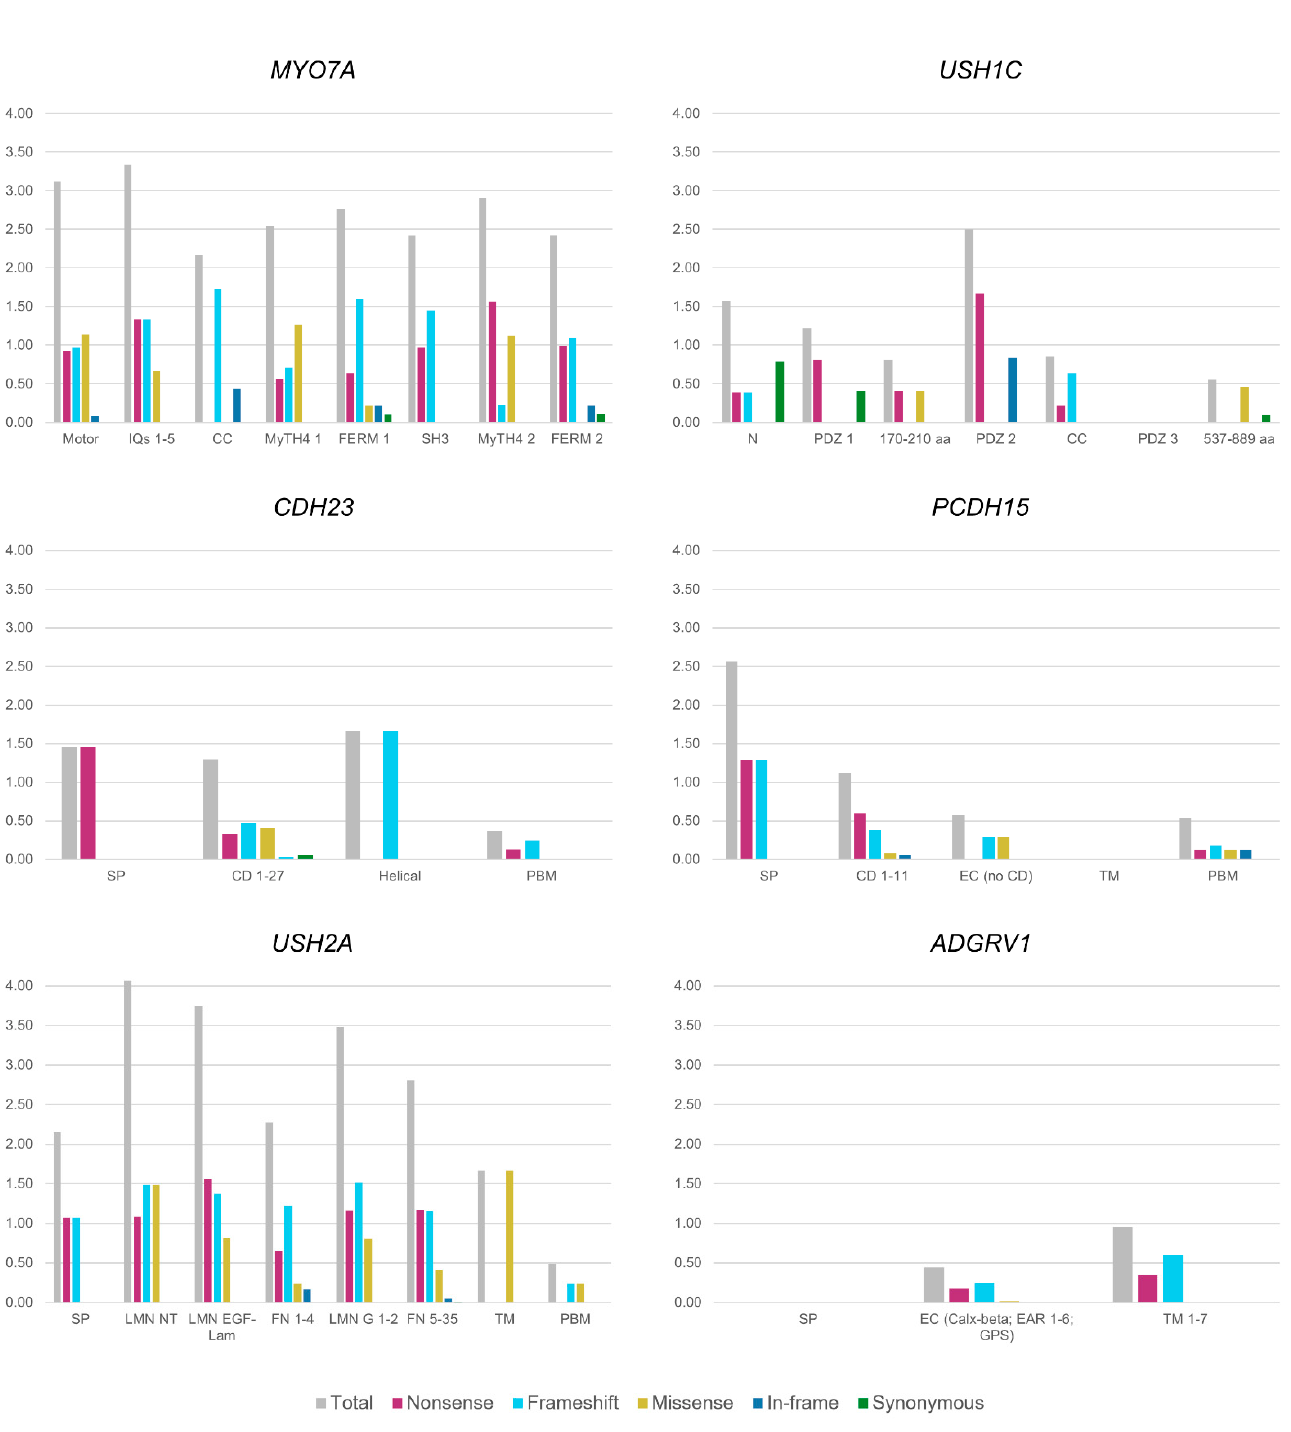
Figure 3. Mutational ratio in USH protein domains. Mutational ratio for the protein domains for the genes MYO7A , USH1C , CDH23 , PCDH15 , USH2A and ADGRV1 , shown on the y-axis. Ratios are calculated counting the number of pathogenic variants of each type located in each domain and normalized with respect to the size of the specific domain. Abbreviations: Motor, motor domain; IQ, IQ calmodulin-binding motif; CC, coil-coiled domain; MyTH4; Myosin Tail Homology 4 domain; FERM, FERM domain (F for 4.1 protein, E for ezrin, R for radixin and M for moesin); SH3; Src Homology 3 domain; N, N -terminal domain; PDZ, PDZ domain; aa, amino acids; SP, signal peptide; PBM, PDZ binding domain; CD, cadherin domains; EC, extracellular domain; TM, transmembrane; LMN NT, laminin N -terminal domain; LMN EGF-Lam, laminin EGF-like domain; LMN G; laminin G domain; FN, fibronectin domain.